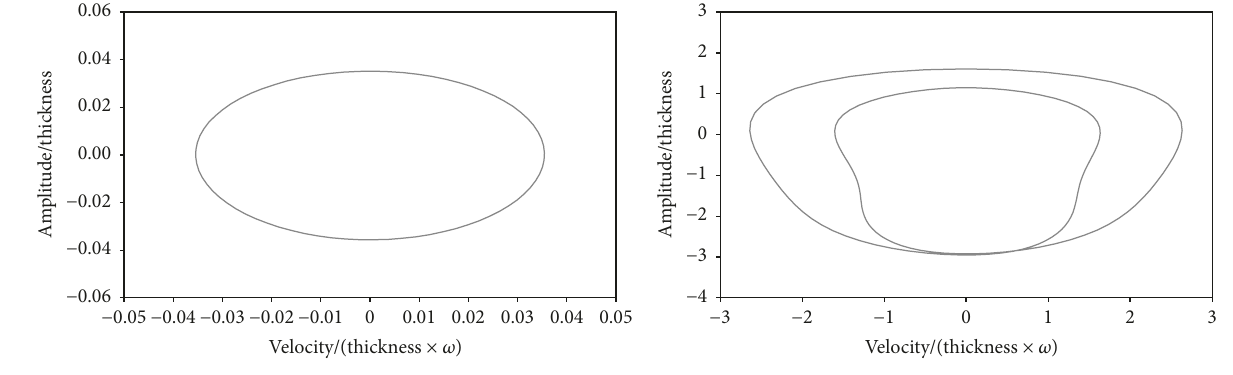
(d) Phase plot for the snap-through case ( ℎ = 2 mm, 𝐿 𝑥 = 0.5 m, 𝐿 𝑧 = 0.3 m, 𝐵 = 0.4 m, 𝜉 = 0.02 , 𝑤 𝑐 = 4 mm, 𝜅 = 30 , 𝜔 = 0.805𝜔 𝑜 )